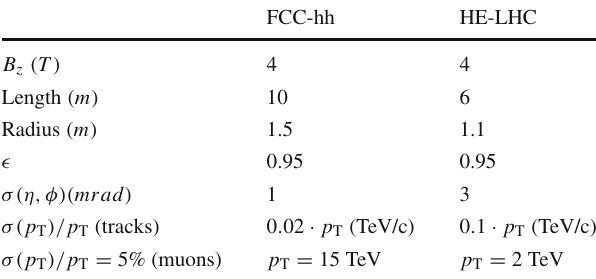
Table 1 Tracking-related parameters for the FCC-hh and HE-LHC detectors in Delphes FCC-hh